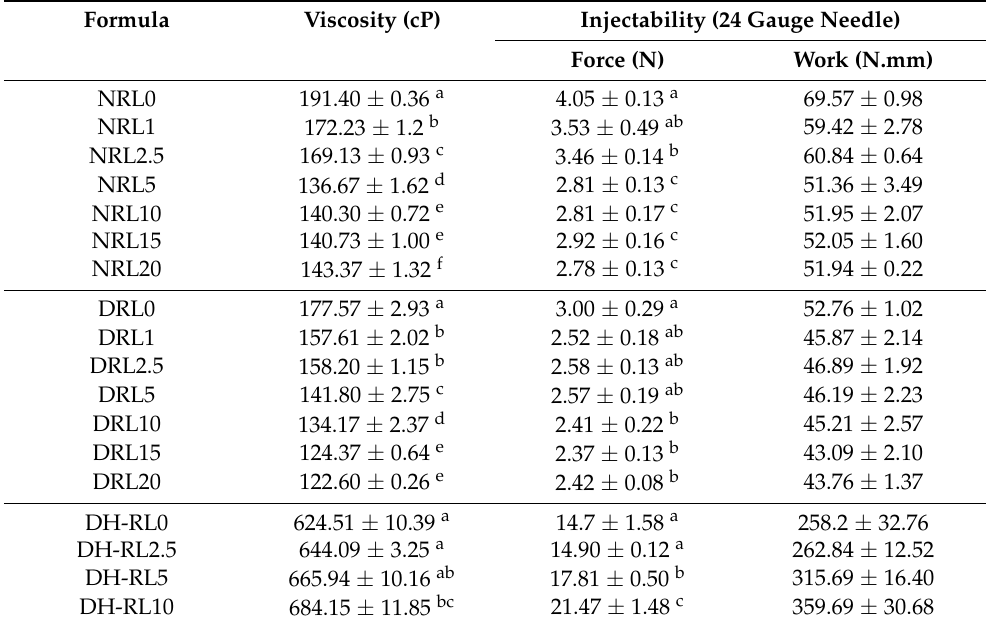
Table 1. Physical properties of drug-free/drug-loaded rosin/LO in situ forming gel systems. Results are shown as mean values ± SD, (n =